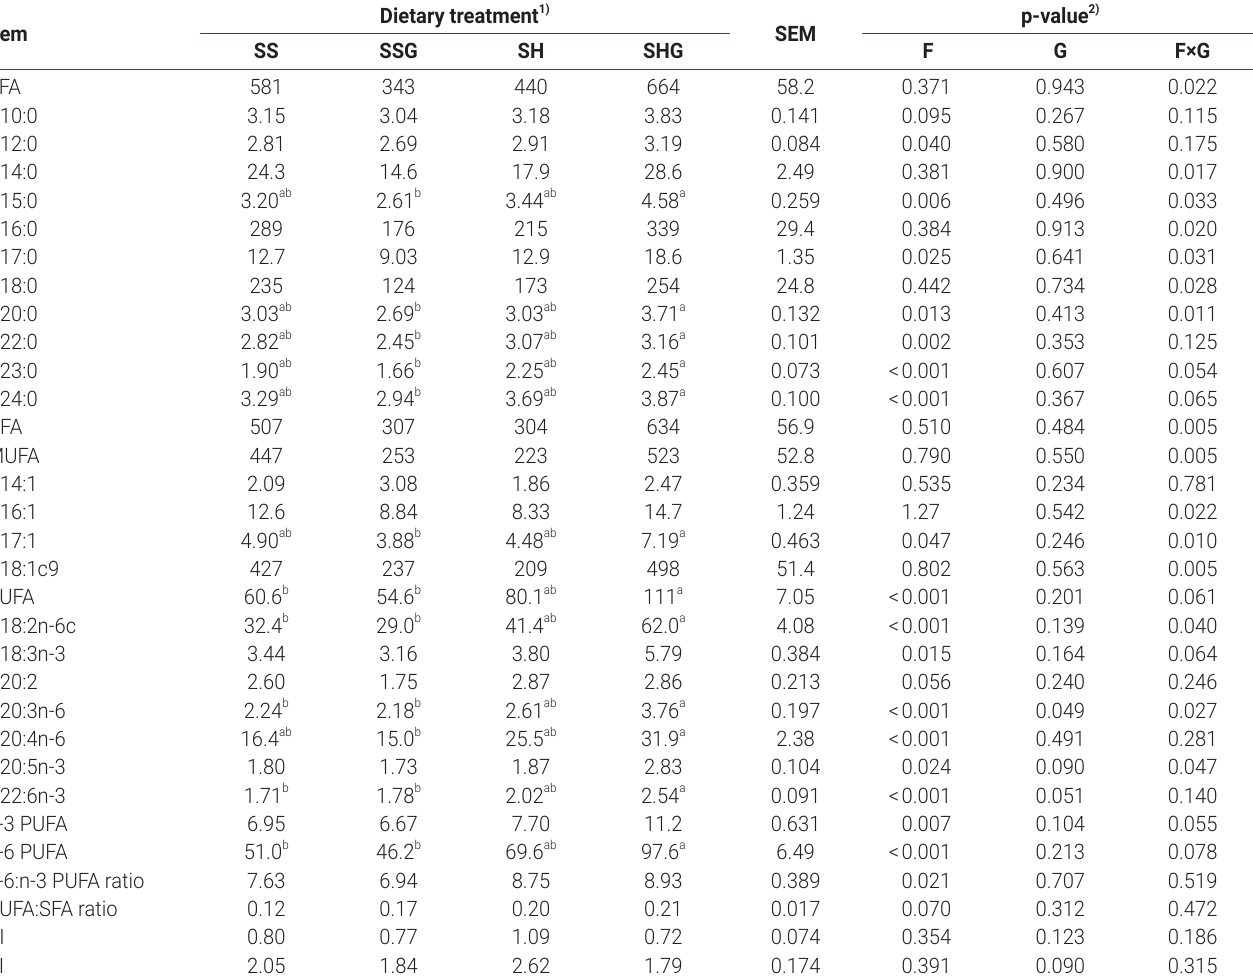
Table 6. Effect of grapeseeds (G) and sweet sorghum forage (F) on fatty acid profiles of Small-tailed Han lamb meat (mg/100 g Longissimus tho- racis tissue) Dietary treatment 1) Item